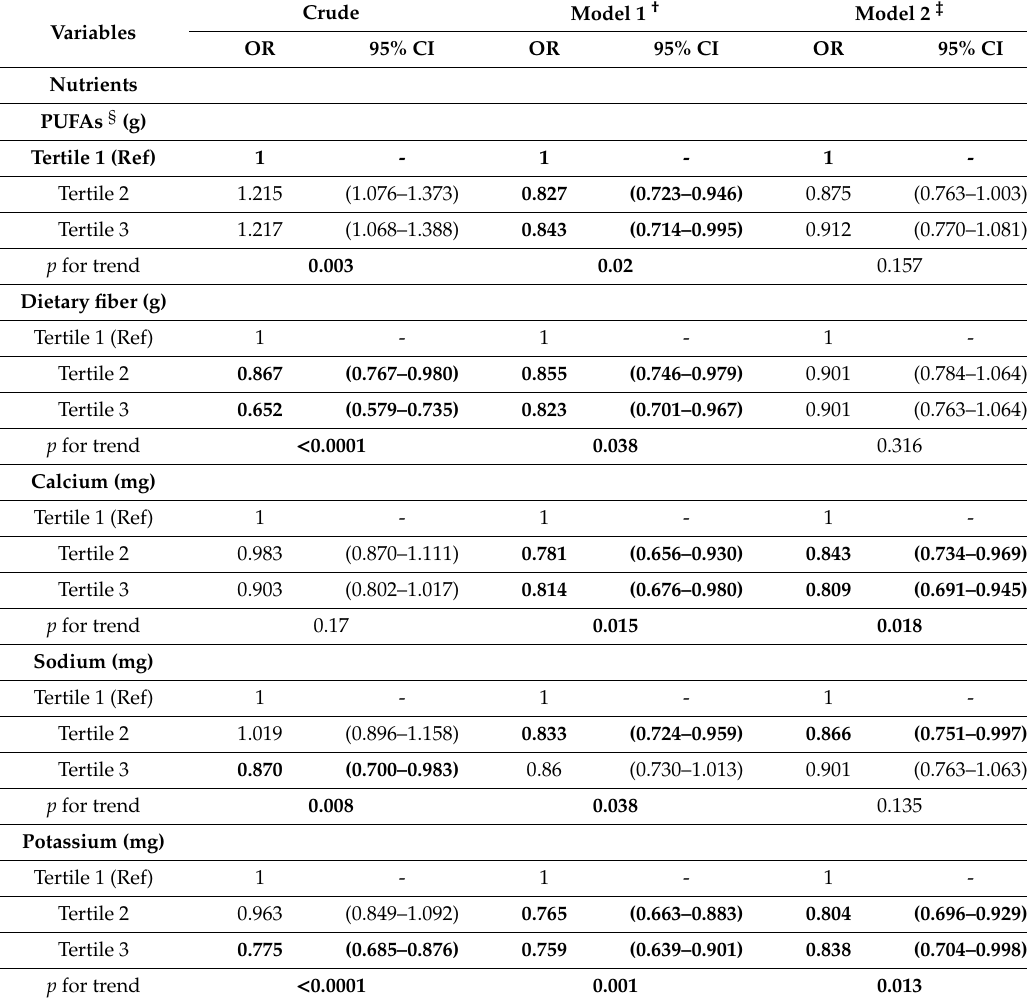
Table 3. Associations (ORs and 95% CIs) between tertiles of nutrients and food consumption and CMP among adults aged from 19 to 64 years in South Korea (KNHANES 2013–2015)